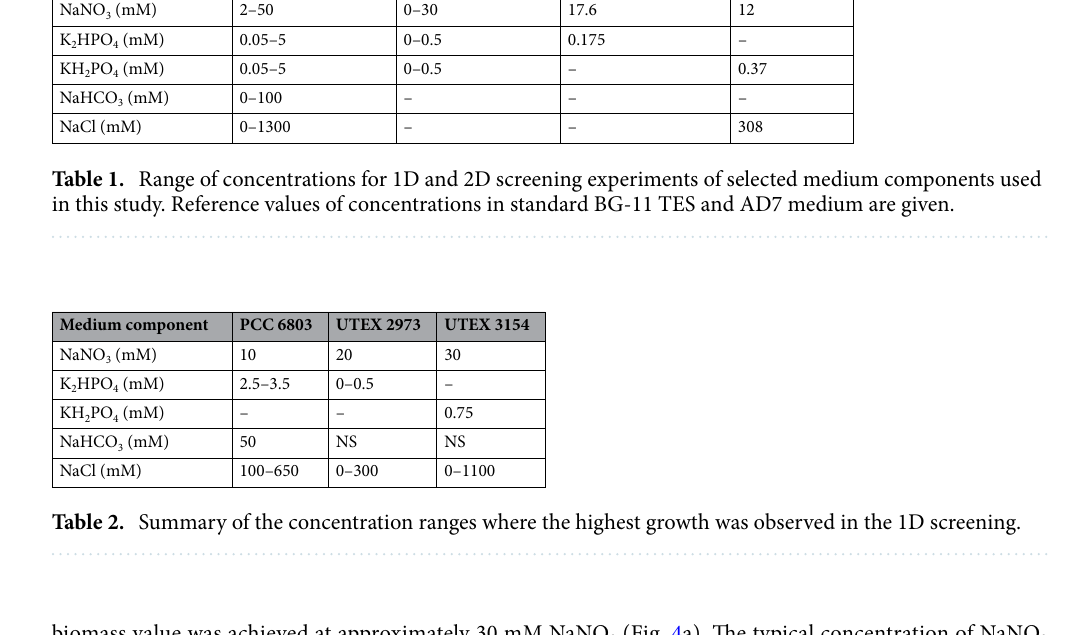
Figure 3. Growth of cyanobacteria in microdroplet setup. Growth kinetics of cyanobacterial strains (UTEX 3154, UTEX 2973 and PCC 6803) in the microfluidic coils measured with multi-channel photo-fluorimeter device showing (a) absorbance (optical density OD) at 470 nm and (b) normalized autofluorescence in the microfluidic setup over a 7 day period. Data points are averages of 50 ± 5 droplets. Error bars represent standard deviation. Normalized autofluorescence is shown as NFU. (c) Image of a microfluidic coil carrying UTEX 2973 droplets. (d) Light microscopy images of cyanobacteria PCC 6803, UTEX 2973 and UTEX 3154 in droplets after 4 days of growth (scale bar: 100 µm). Medium component